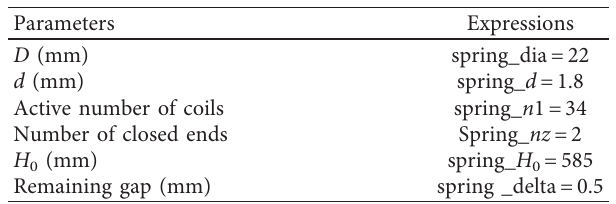
Figure 4: Schematic diagram of the 3D modeling process of three-wire recoil spring. Table 2: Driving parameters of three-wire recoil spring.